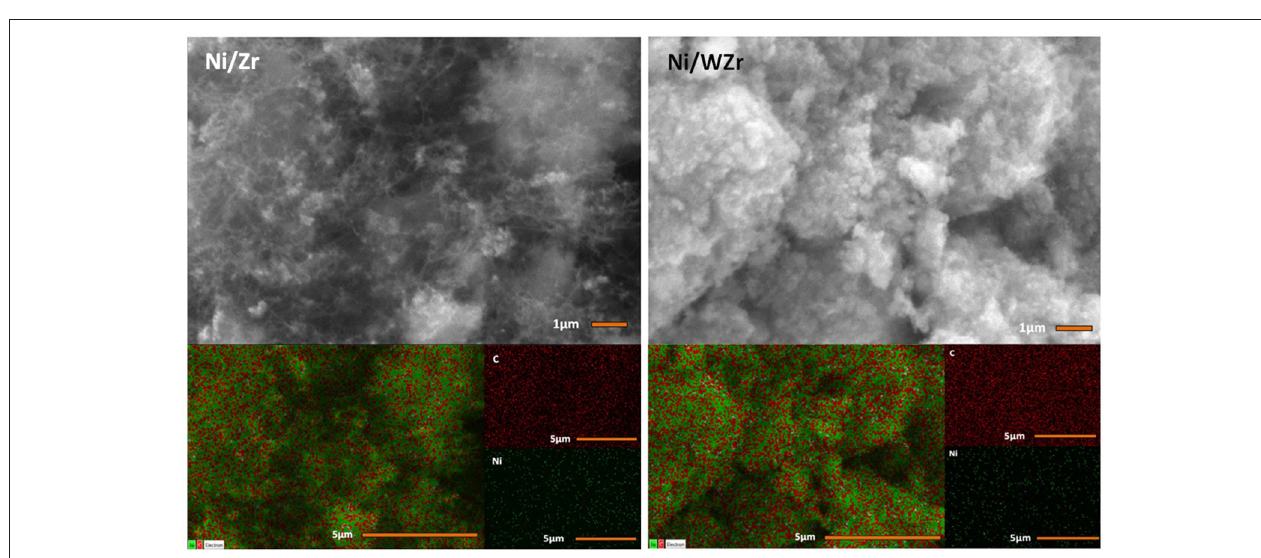
FIGURE 5 | SEM images and carbon mapping of spent